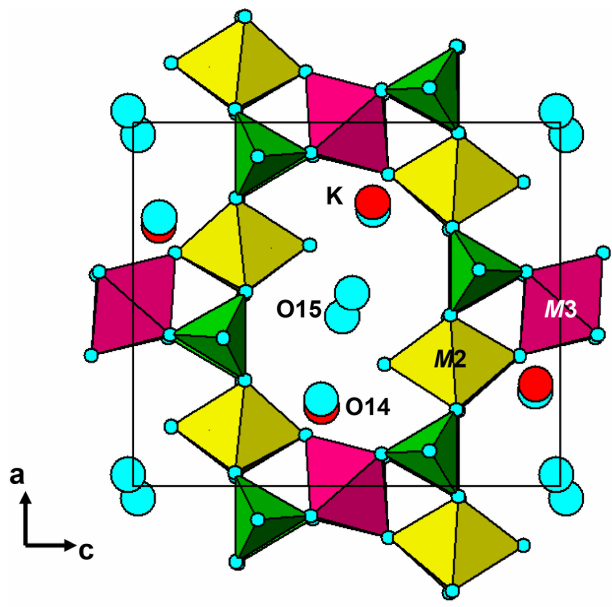
Figure 5. { 010 } slice of the pleysteinite structure.